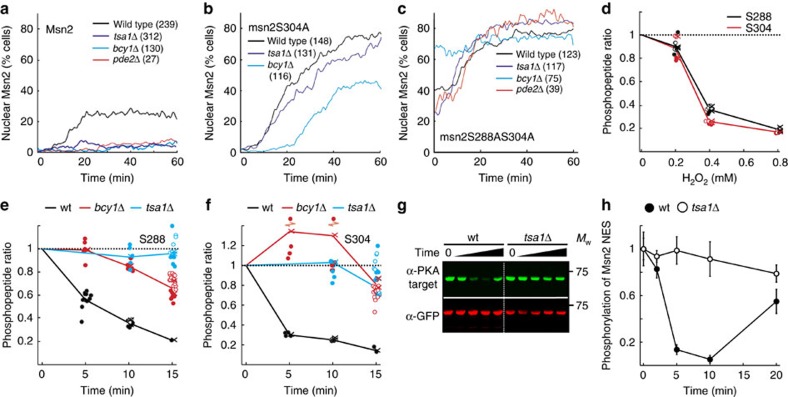
Tsa1 controls Msn2 translocation to the nucleus upon illumination and H2O2 by reducing Msn2 phosphorylation.(a–c) Fraction of cells of the indicated strains displaying nuclear localization following illumination at 115 μW. Cells were transformed with plasmids carrying either wild-type or mutant Msn2 alleles as indicated. The number of cells assayed in each analysis are indicated in brackets. (d–f) SILAC-based MS quantification of Msn2 phosphopeptides spanning the indicated NES serines following the addition of the indicated amount of H2O2 for 10 min to the wild type (wt) (d) or 0.4 mM H2O2 for the indicated time to the indicated strains (e,f). Average ratios (H2O2-treated/untreated) of Msn2 phosphopeptides measured by quantitative MS in two biological replicates are shown, the individual values of which each is indicated by a cross. Closed and open circles denote individual peptide ratios quantified in biological replicate 1 and 2, respectively (see Methods and Supplementary Data 1 and 2 for details). (g,h) Msn2 NES phosphorylation determined by immunoblot analysis of immunoprecipitated Msn2 expressed from plasmid pAMG9 (ref. 8) and an antibody recognizing phosphorylated PKA target sequences. The average phosphorylation signal on the membranes (g) was quantified by densitometric analysis and normalized to the anti-GFP signal (h, n=3). Error bars indicate s.d. See also Supplementary Fig. 3n.